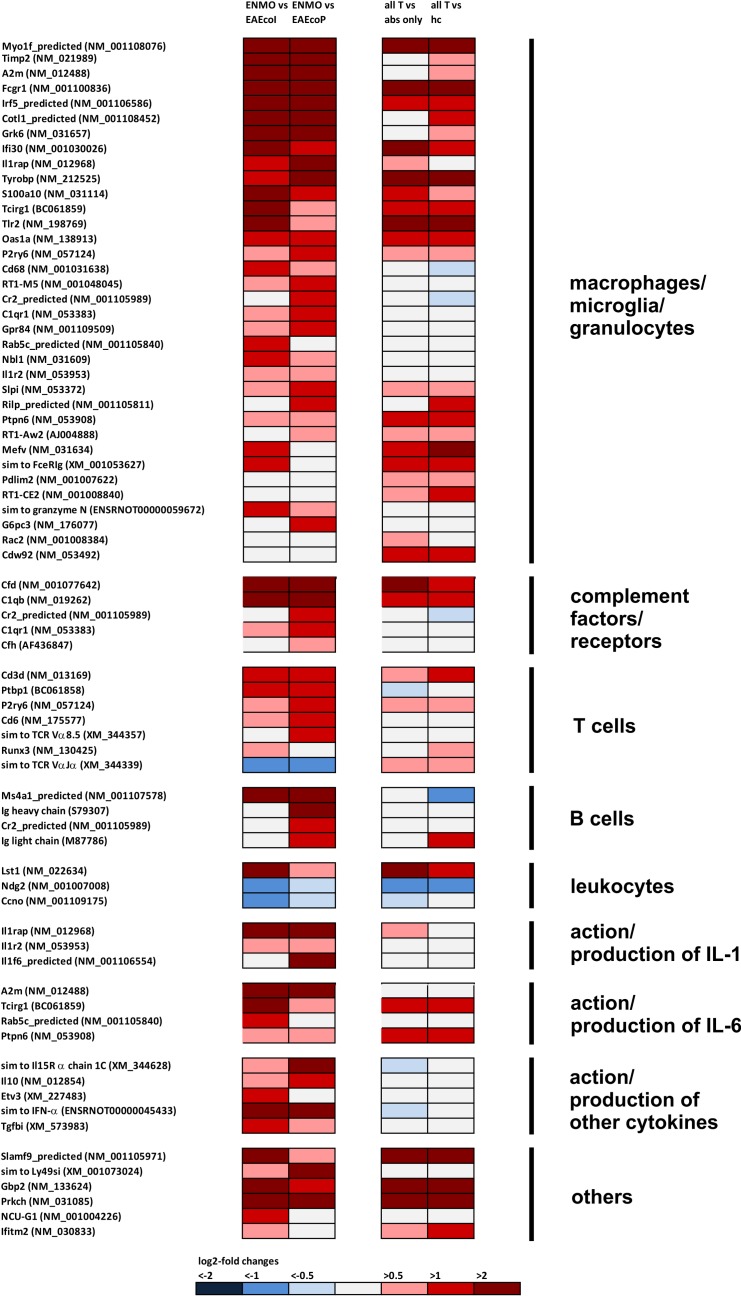
Footprints of inflammatory processes in the spinal cord, as revealed by microarray analysis.In the first column of pairwise comparison of log2-fold changes in gene expression, mean values were compared between rats receiving T cells and NMO-IgG (ENMO, n = 5) and their counterparts receiving T cells and subcuvia as control IgG (EAEcoI, n = 5) or T cells and PBS (EAEcoP, n = 5). In the second column of pairwise comparison of log2-fold changes in gene expression, mean values were compared between a group containing all ENMO plus EAEcoI plus EAEcoP animals (n = 15, “all T”) and a group containing animals injected with antibodies only (“abs only” (5 animals with NMO-IgG plus 5 animals with subcuvia as control IgG) or containing healthy control animals only (“hc”, n = 3).